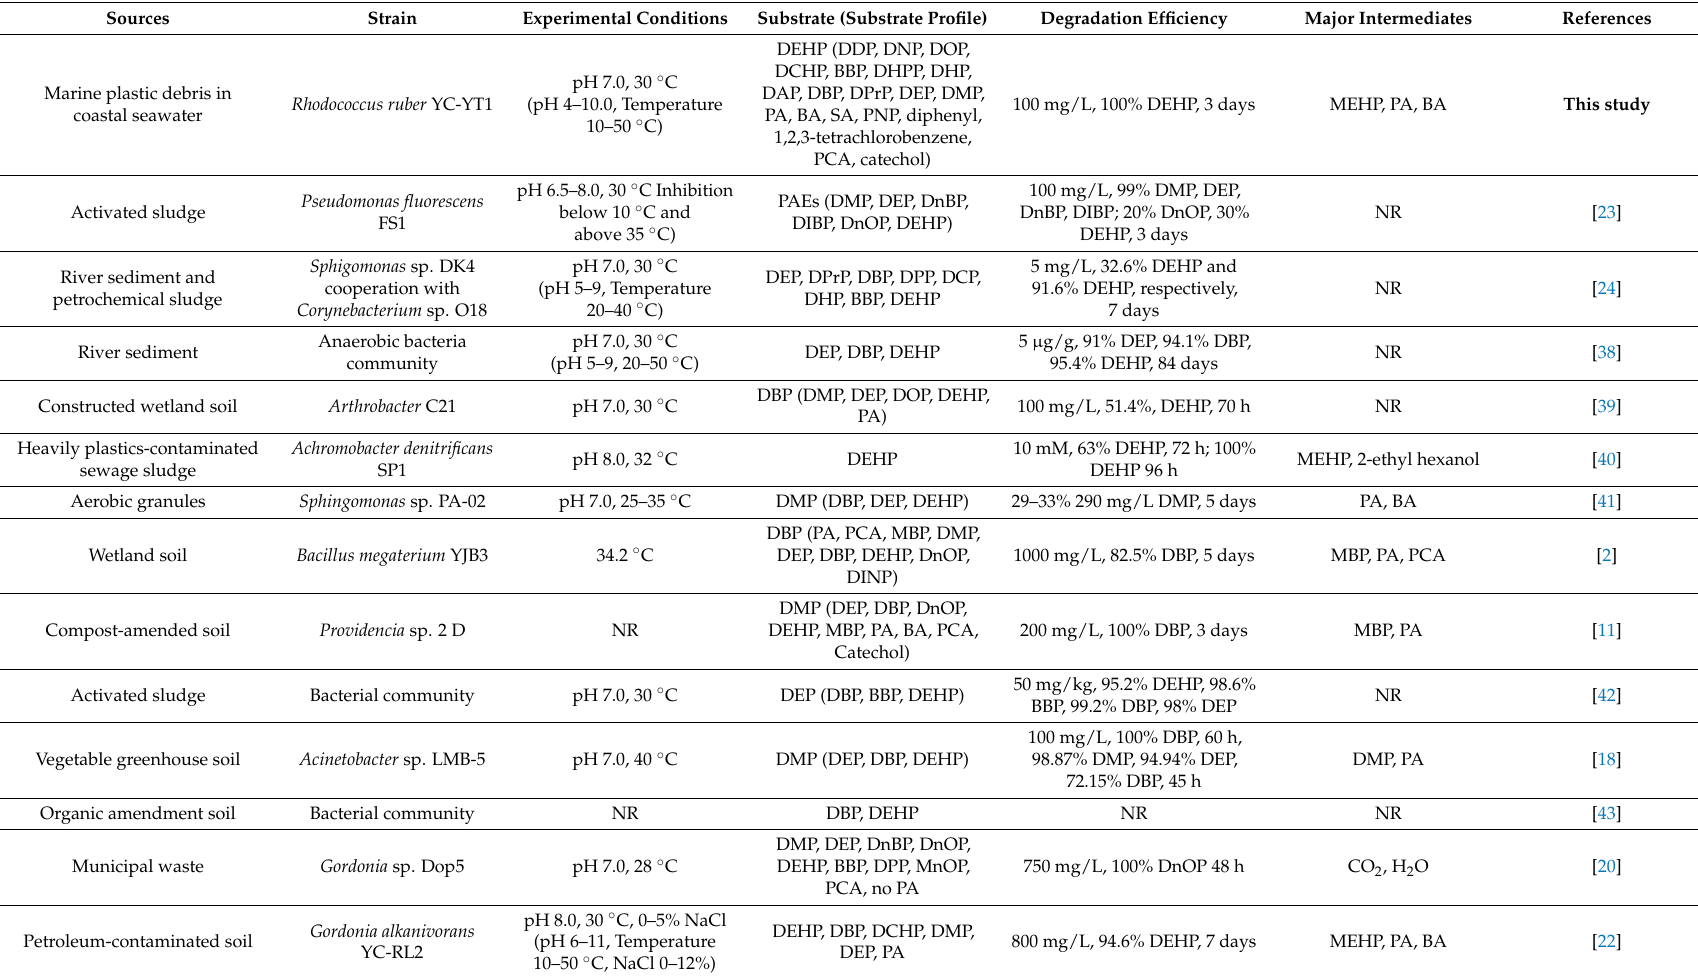
Table 1. Typical di-(2-ethylhexyl) phthalate (DEHP)-degrading bacteria strains and their